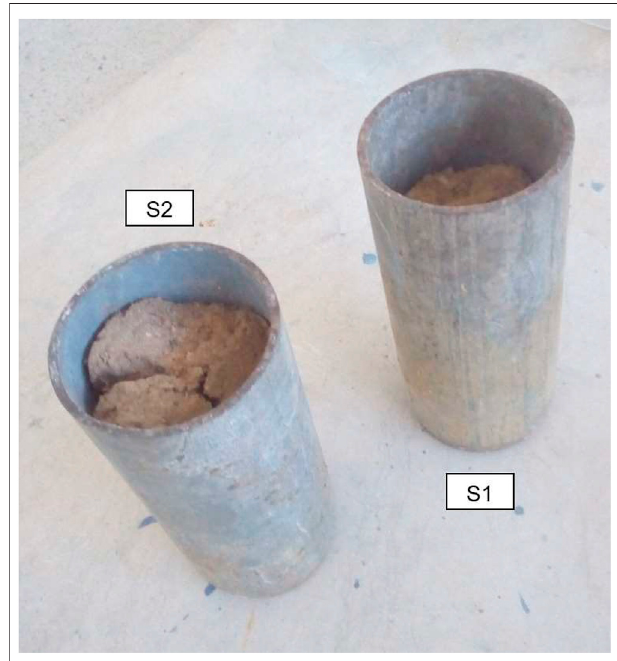
FIGURE 10 | Two cored specimens extracted at ENIT, Tunis El Manar University, Tunisia.